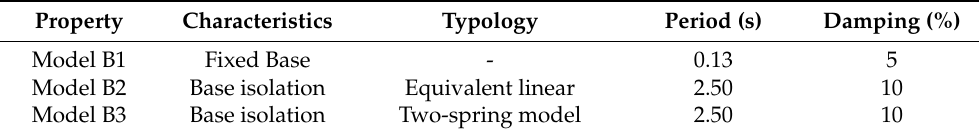
Table 1. Performed models.